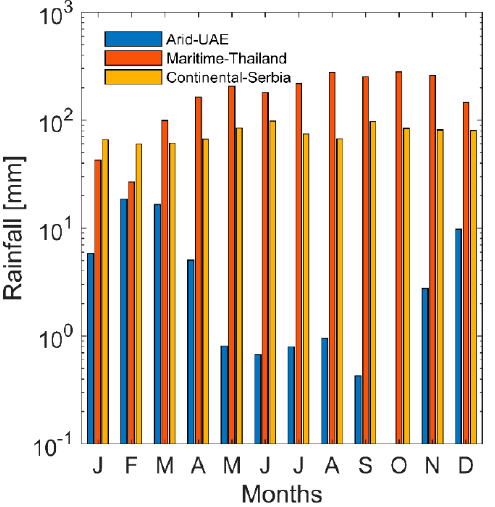
Figure 2. Average monthly rainfall for three investigated regions in the period 1991–2016. The 𝑦 -axis is logarithmic in order to depict the small values of precipitation in the arid region of the UAE. Data source: [35] (obtained at: http://sdwebx.worldbank.org/climateportal/ ).